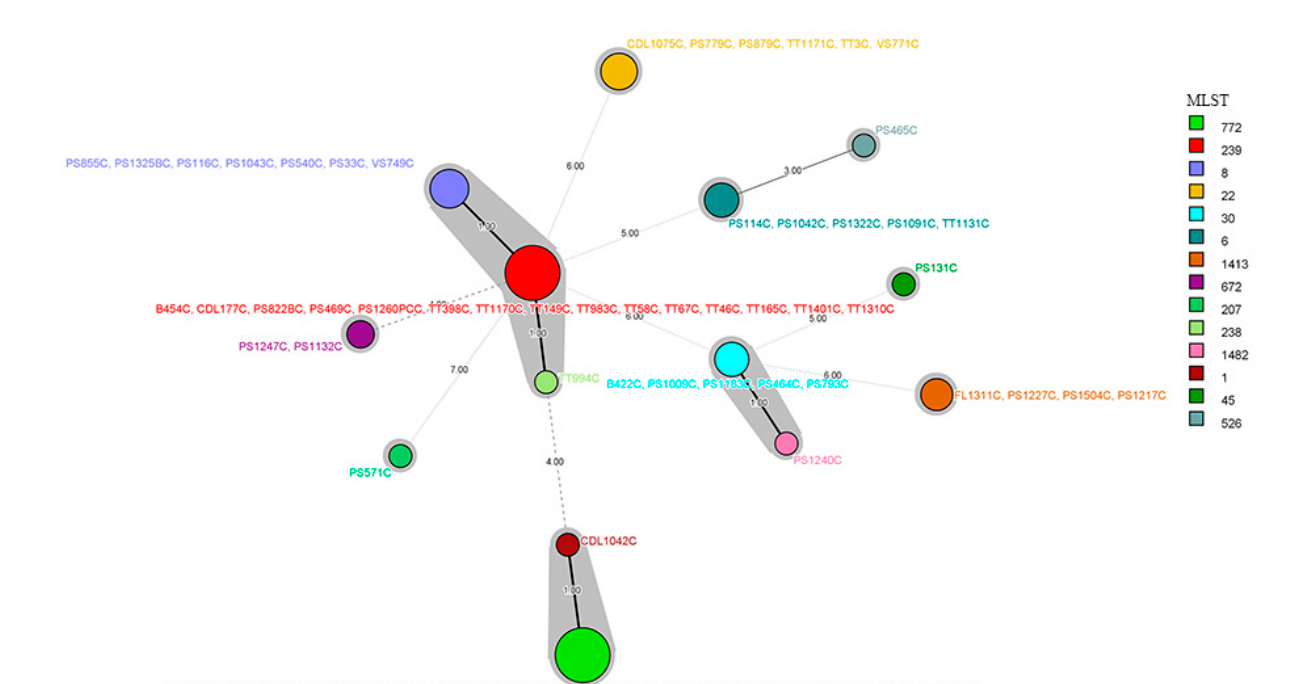
Figure 3. Minimum spanning tree (MST) of Multilocus Sequence Typing (MLST) of the examined clinical Staphylococcus aureus from humans. Each circle corresponds to an individual MLST type; the circle size is proportional to the number of isolates belonging to the same MLST type. The color of each circle denotes the MLST type. Connecting lines (solid and dashed) between circles represents allelic variations between MLST types; the grey shadowing indicates no more than one different loci between MLST types.